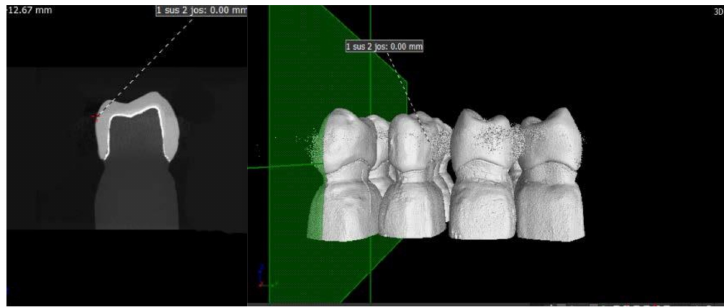
Figure 5. Images from the micro-CT program for the FP